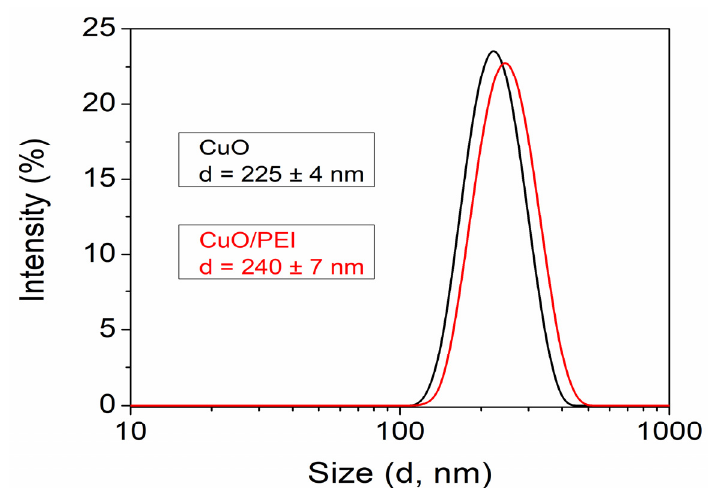
Figure 2. Particle size distribution.